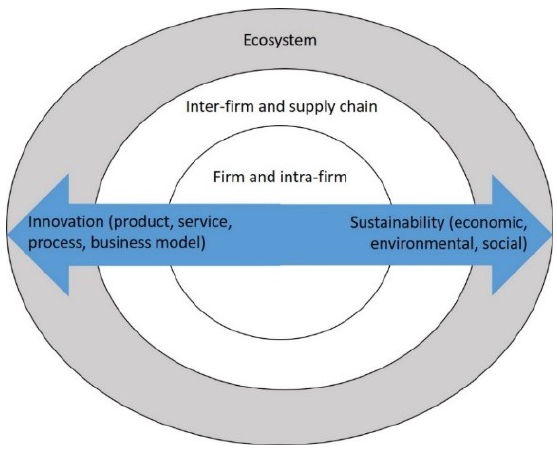
Figure 1. Research scope.